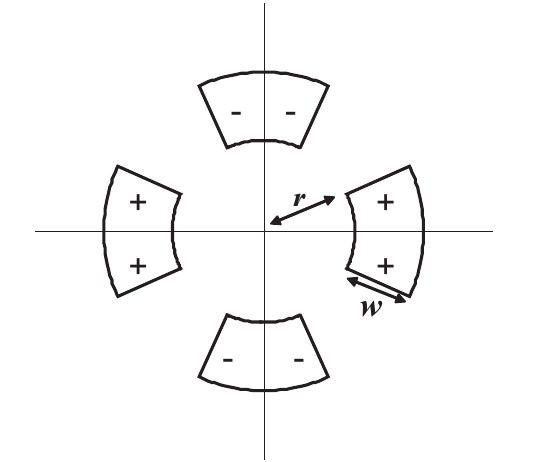
FIG. 2. Layout of a 30 (cid:9) sector coil for a quadrupole of aperture radius r and coil width w .